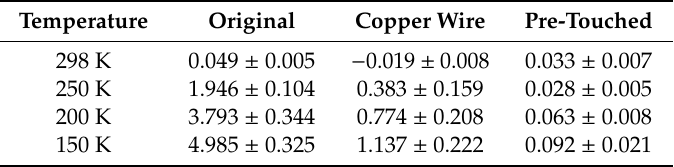
Table 1. Thermal drift rate under di ff erent cooling methods (nm / s)